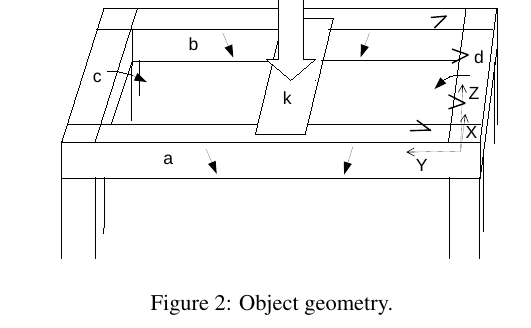
Figure 2: Object geometry.